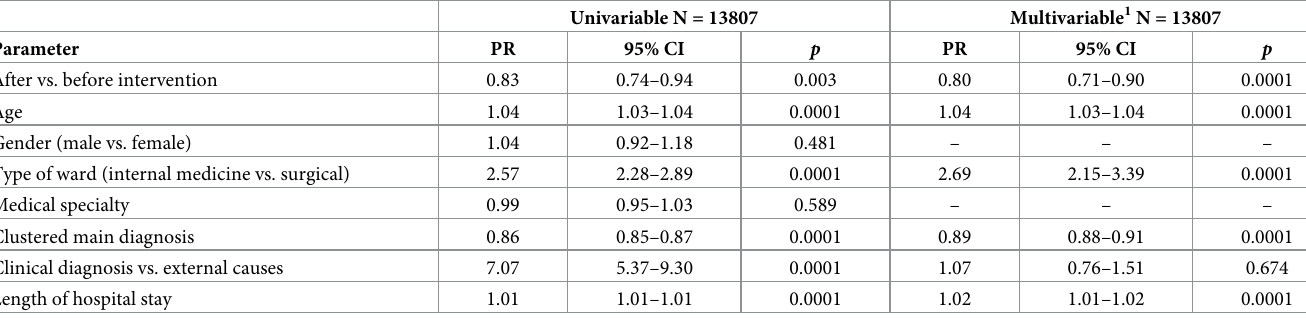
Table 2. In-hospital mortality predictors in univariable and multivariable